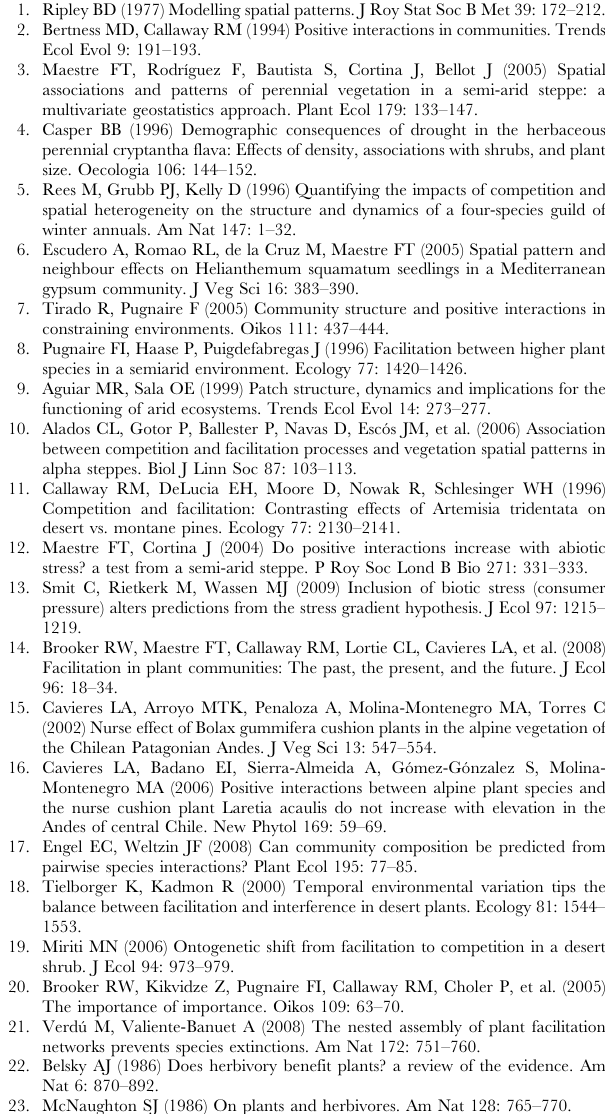
Table S1 Life form, abundance ( n i ), co-occurrences ( a i ) and association type ( ass ) of plant species in Cabo de Gata-Nı´jar Natural Park along grazing gradient. Associ- ation values are presented for species that could distinguish between neutral and negative associations.